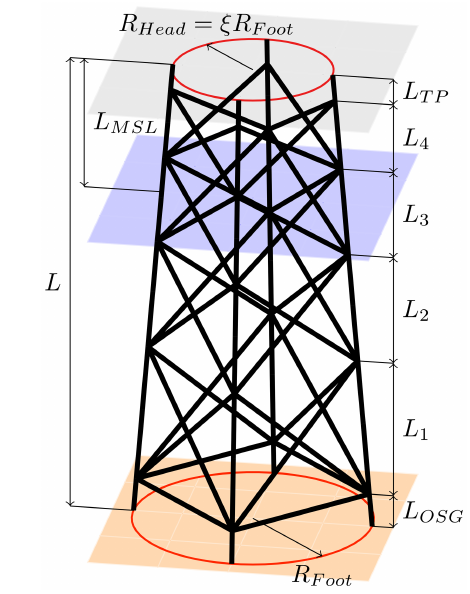
Figure 1. Jacket geometry model with variables characterizing the topology of the structure, shown exemplarily for a jacket with four legs, four bays, and mud braces. The ground layer is illustrated by the orange surface and the mean sea level and transition piece layers by the blue and gray surfaces,